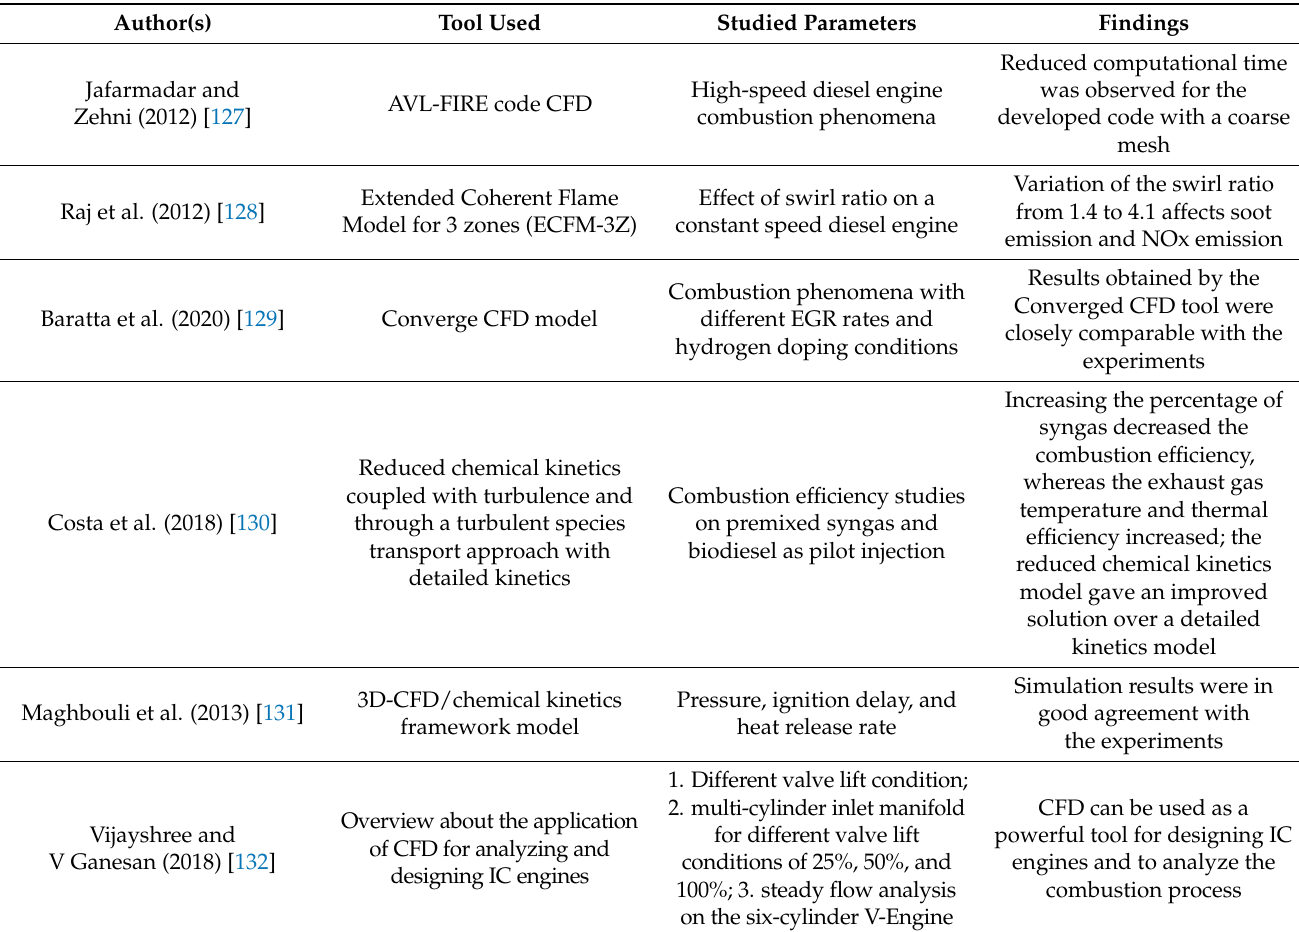
Table 3. A summary of articles related to combustion